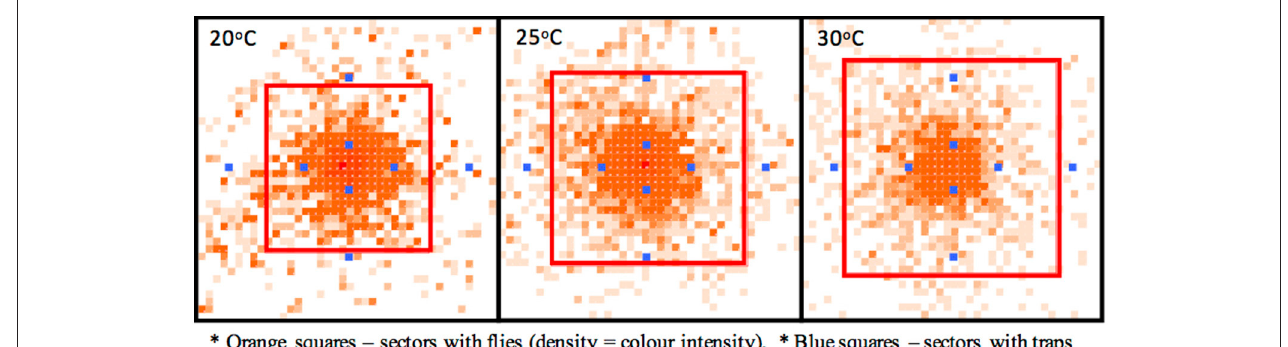
FIGURE 3 | Effects of temperature on